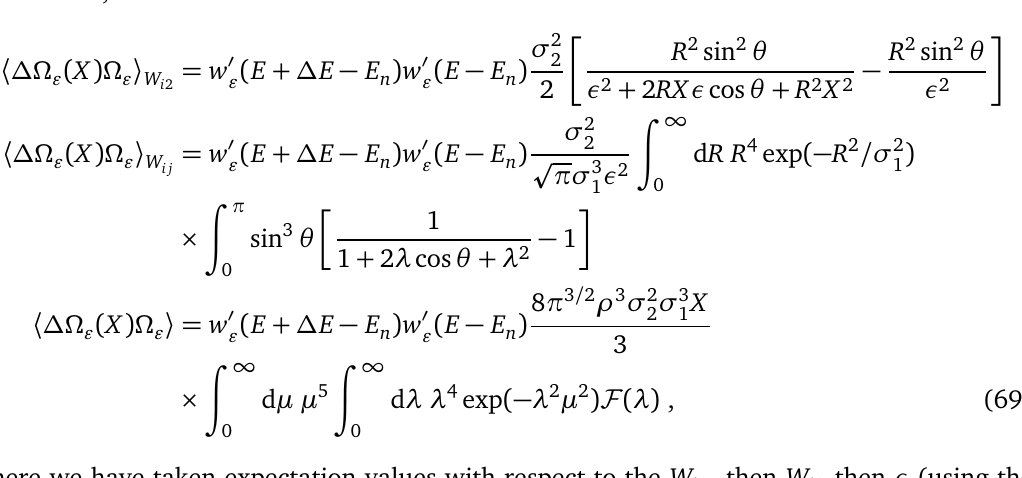
(cid:112) / M = 0,1 / 2,1,3 / 2 and fixed width (cid:34) = π/ 0